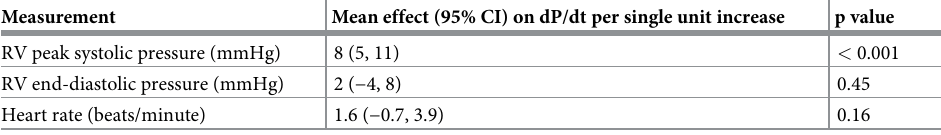
Table 5. Effect of confounding hemodynamic factors on the measurement of RV dP/dt.